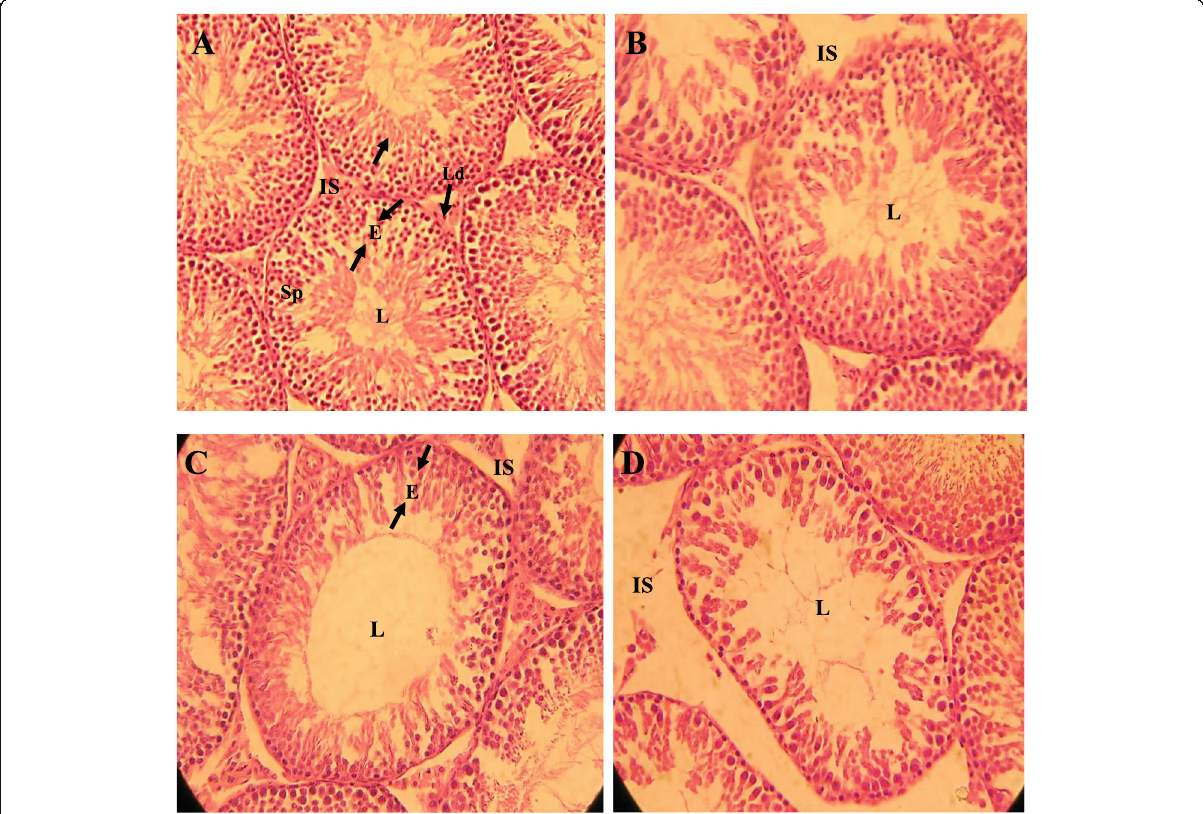
Fig. 1 Photomicrograph from testicular tissue showing a control; with a compact arrangement of seminiferous tubules having thick epithelium containing normal spermatogonia and sperm-filled lumen ( b ) BPS (0.5 μ g/L)-exposed group, presenting normal seminiferous tubules with thick epithelium with different cell types ( c ) 5 μ g/L of BPS-exposed group, presenting seminiferous tubules with different cell types and arrested spermatogonia and round spermatids ( d ) 50 μ g/L of BPS-exposed group presenting seminiferous tubules with thin epithelium and arrested spermatogonia and elongating spermatids and empty lumen. H&E (×